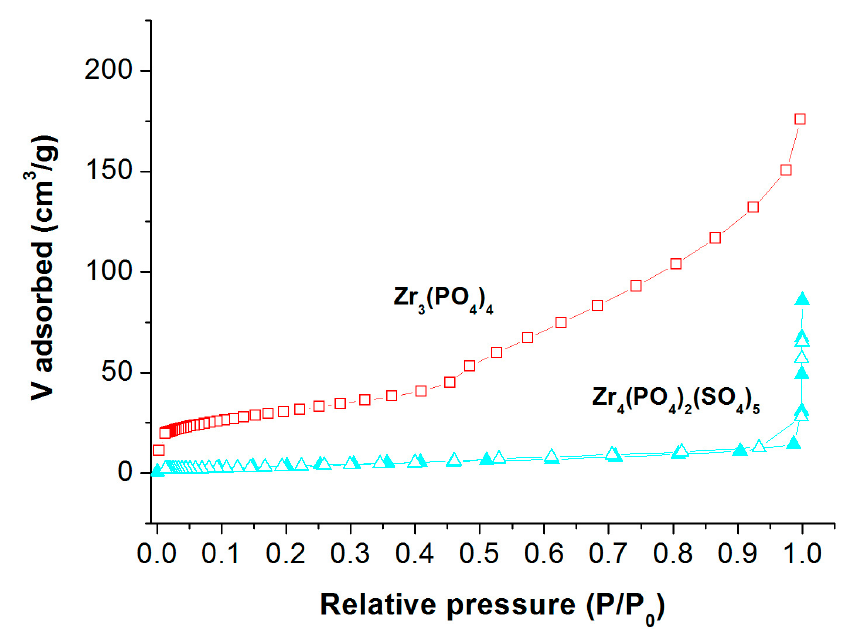
Figure 2. N 2 adsorption-desorption isotherms for two selected samples, Zr 3 (PO 4 ) 4 and Zr 4 (PO 4 ) 2 (SO 4 ) 5 .